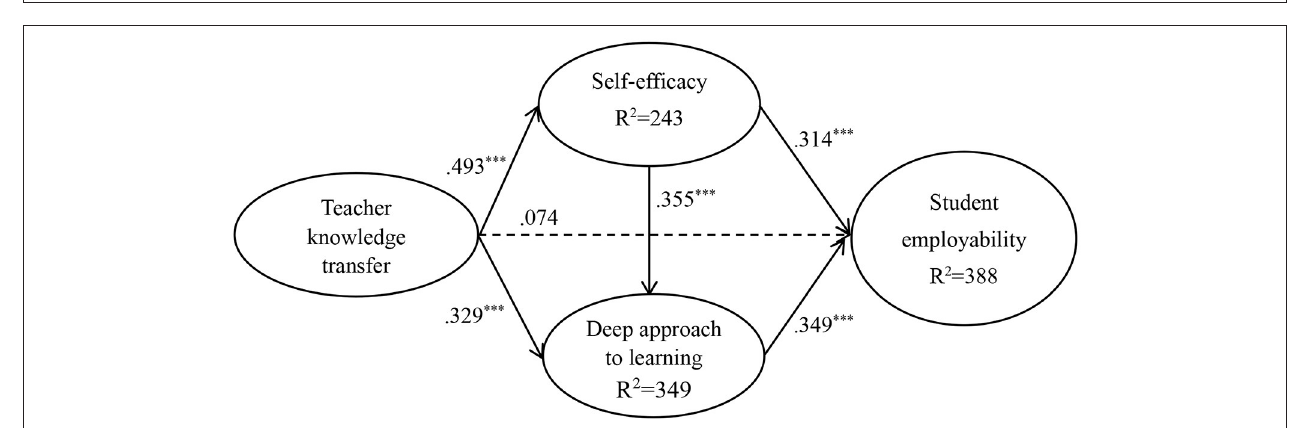
FIGURE 2 | Structural model on Taiwanese student.